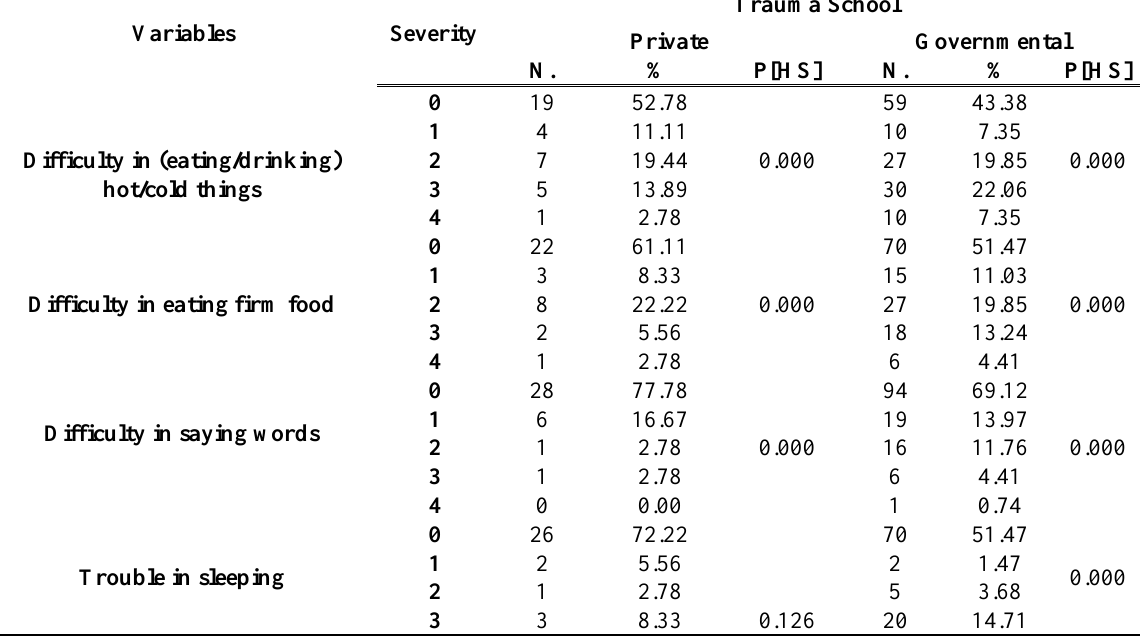
Table (4b): The association of traumatic dental injuries and quality of life regarding functional limitation by school